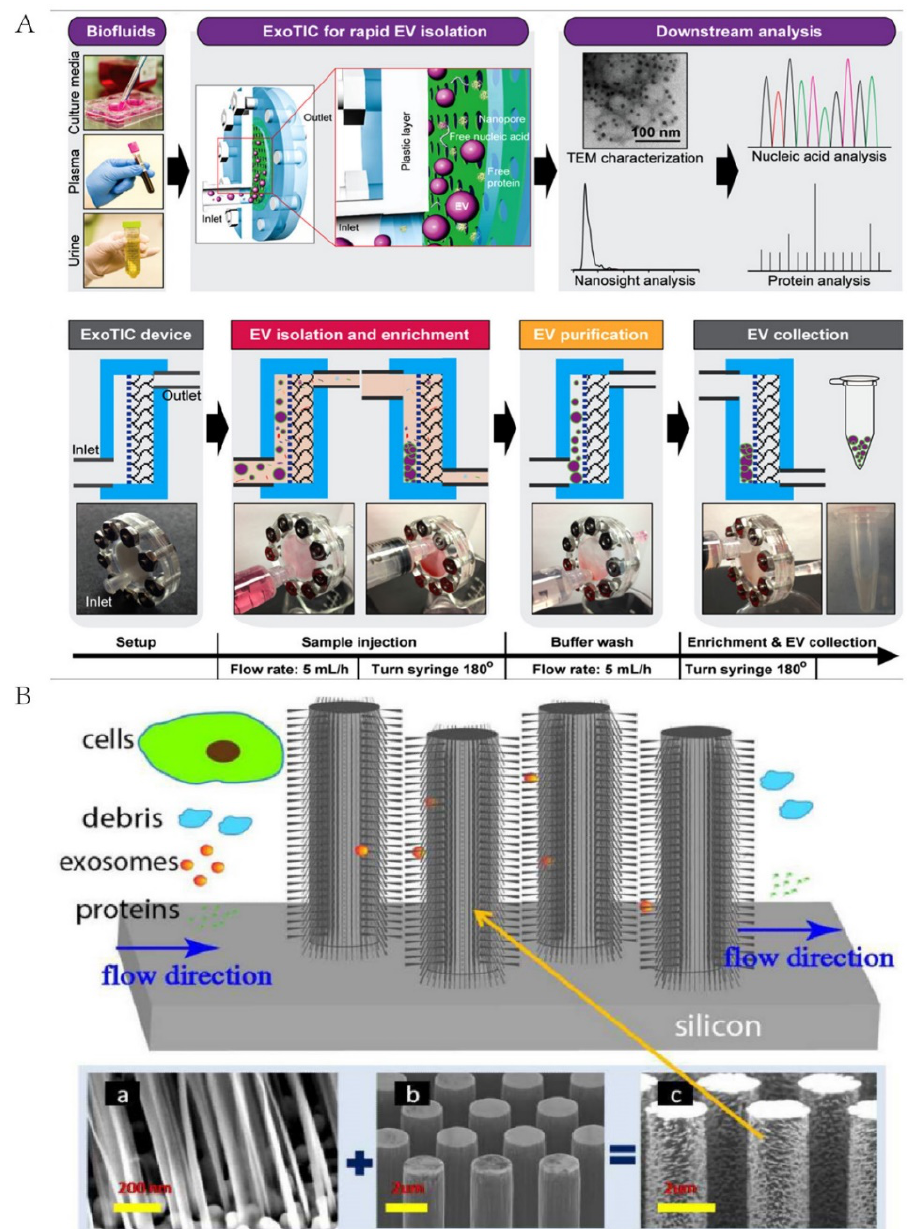
Figure 3. Microfluidic technology for exosome isolation based on filtration. ( A ) Schematic of ExoTIC device used by Liu et al. Reprinted with permission [45] . ( B ) Schematic of ciliated micropillar nanowires coated with nanowires. Reprinted with permission [46] .